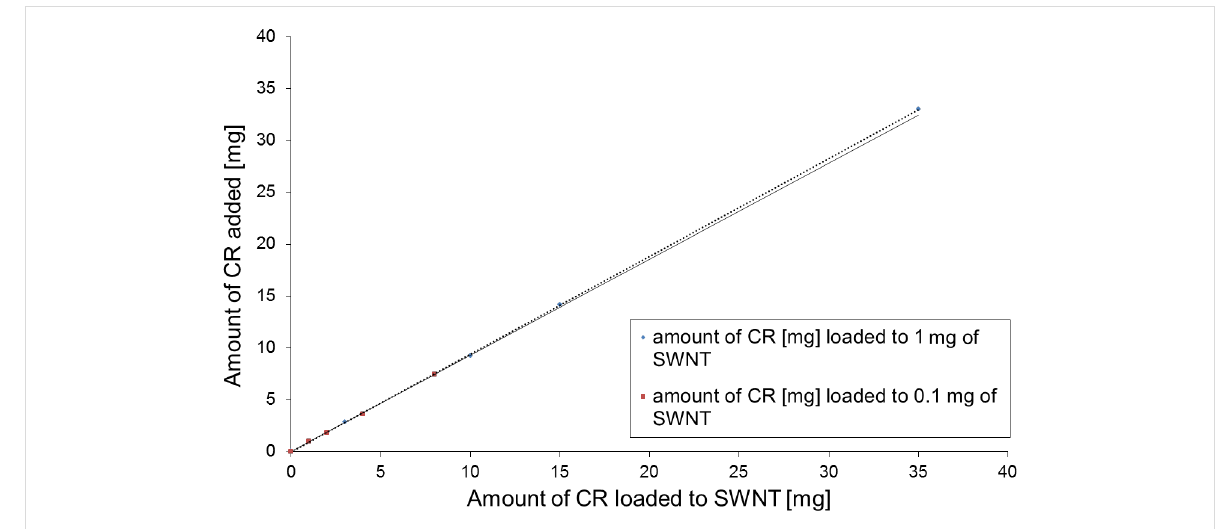
Figure 5: SWNT–CR complexes formed at different CR/SWNT ratios. Macroscopic images of complexes filtered on PTFE membrane and suspended in pH 7.4 0.05 M Tris/HCl buffer. (A) 1 mL of 2 mg/mL CR added to 1 mg of SWNTs – the complex retained its colloidal stability for up to 3 months; (B) 1 mL of 5 mg/mL CR added to 1 mg of SWNTs – the gel-like, time-sedimenting (arrow) (C), but easily dispersed com- plex was